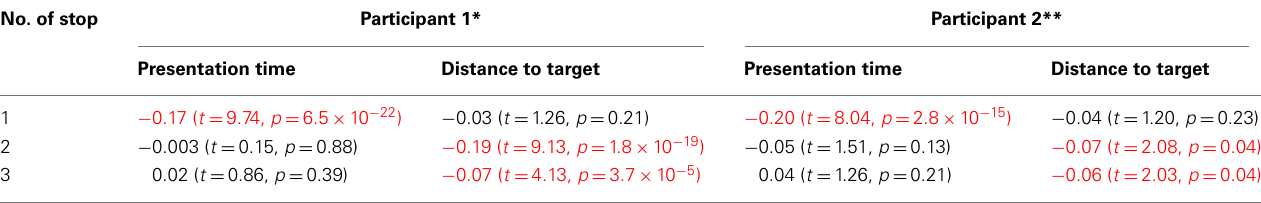
Table 1 | Correlation coefficients and statistics of stop duration (for the first, second, and third stops) with presentation time and distance to